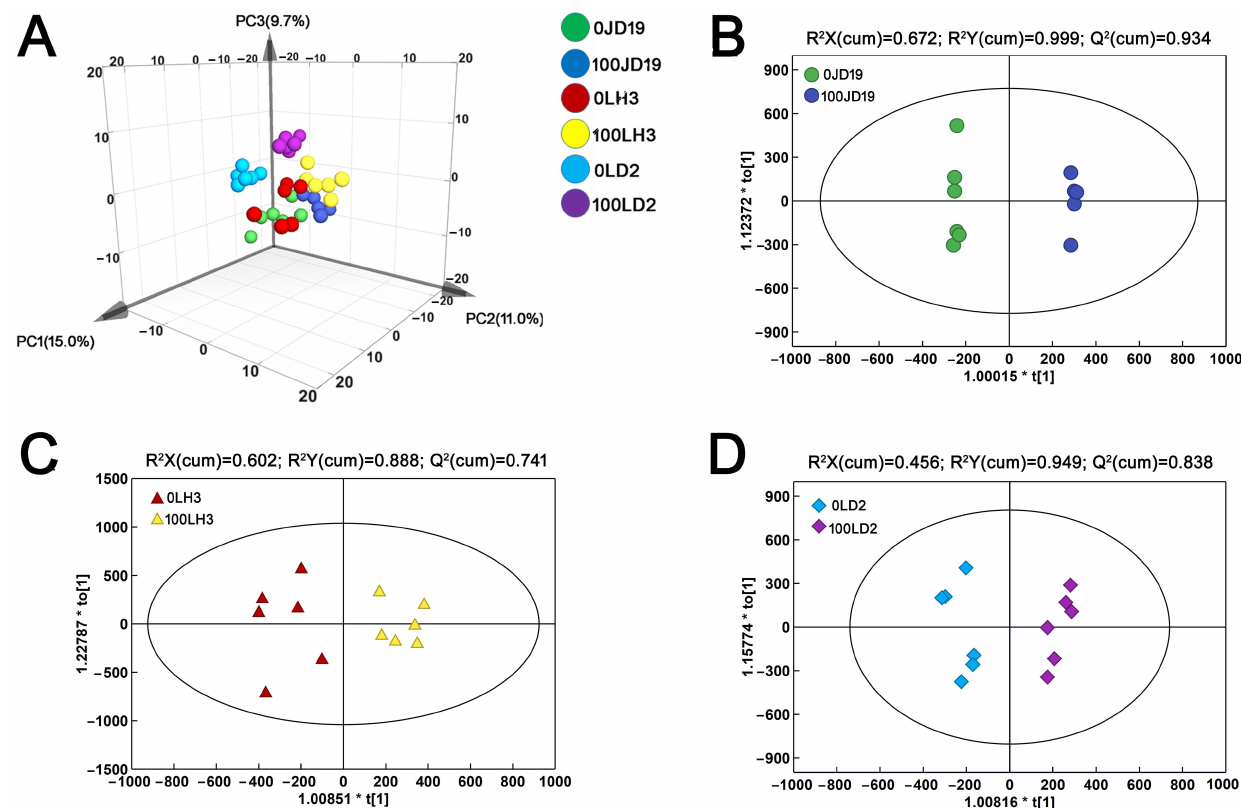
Figure 5. PCA diagram ( A ), and OPLS-DA scatter diagram of JD19 ( B ), LH3 ( C ), LD2 ( D ) under control and 100 mM NaCl treatment.